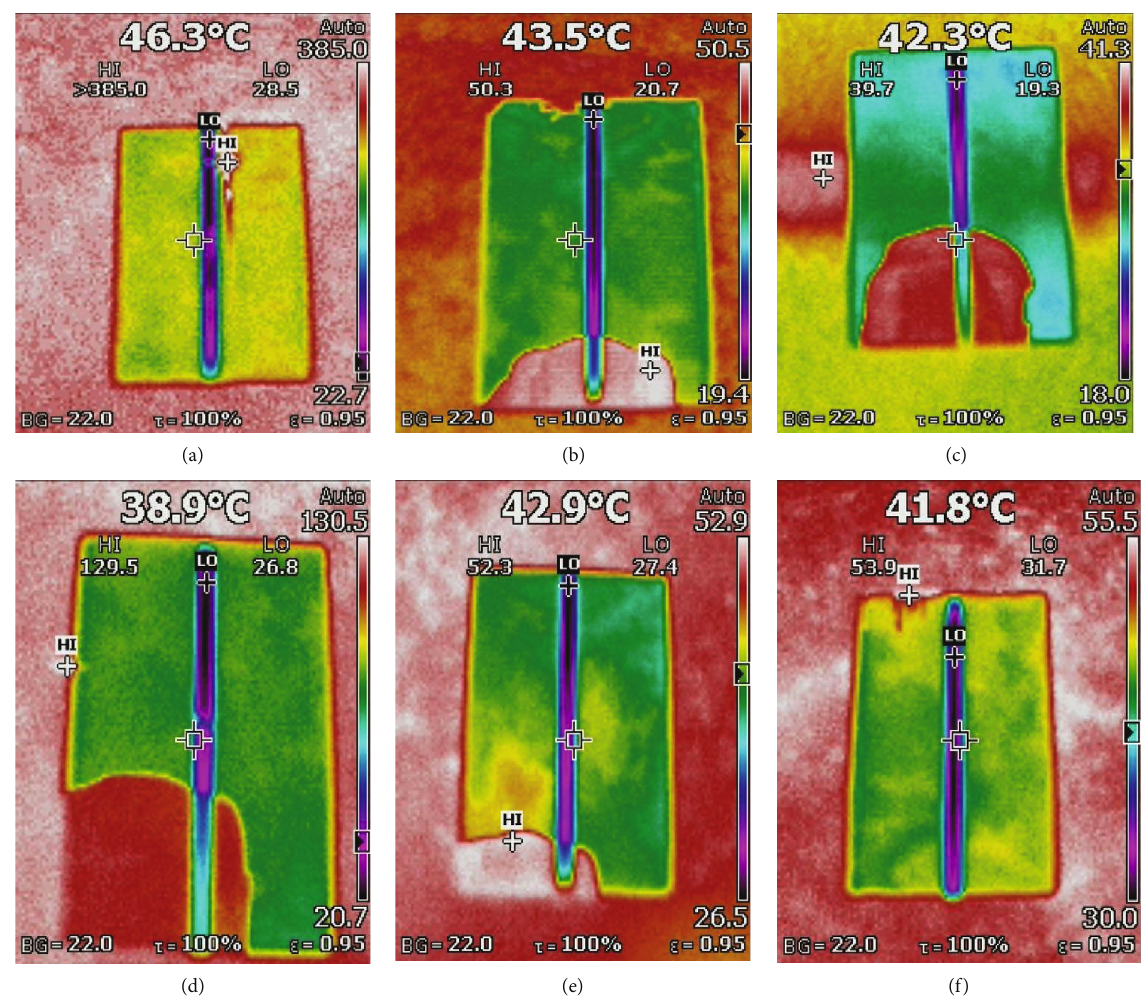
Figure 13: Temperature analysis under direct sunlight: (a) A-I (uncoated solar cell), (b) A-II, (c) A-III, (d) A-IV, (e) A-V, and (f)